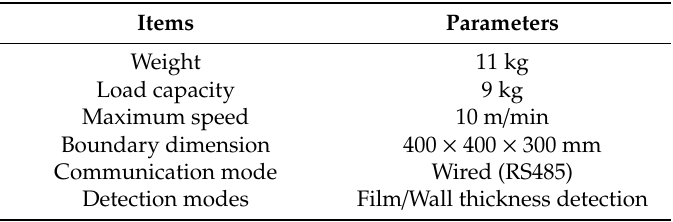
Table 5. Keys technical parameters of the robot.